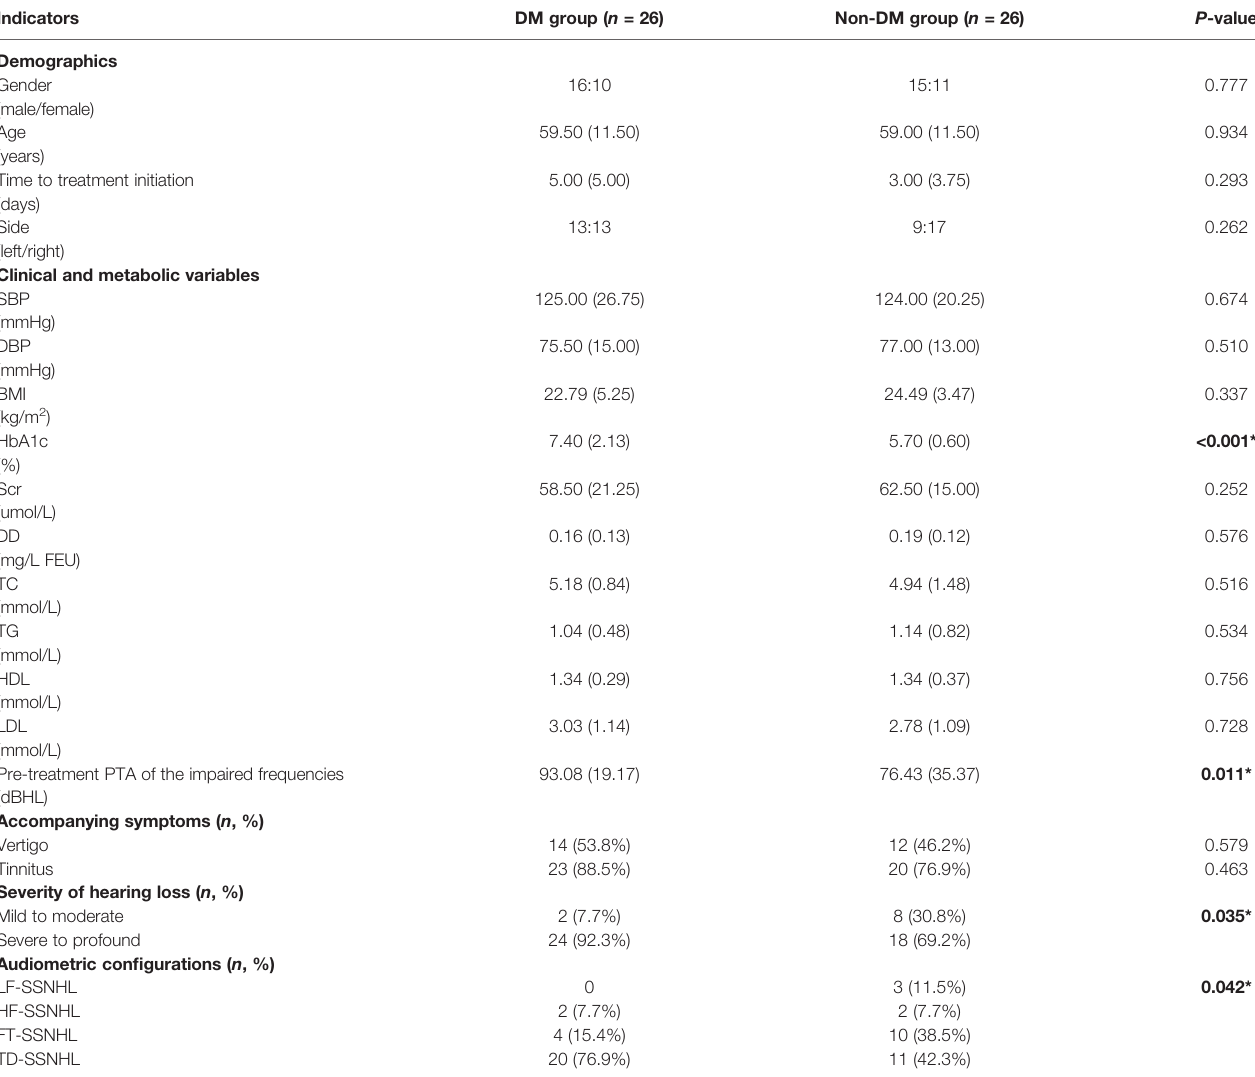
TABLE 2 | Pathogenic features in the matched data set after propensity score matching using “ age ” as the predictor. Indicators DM group ( n =